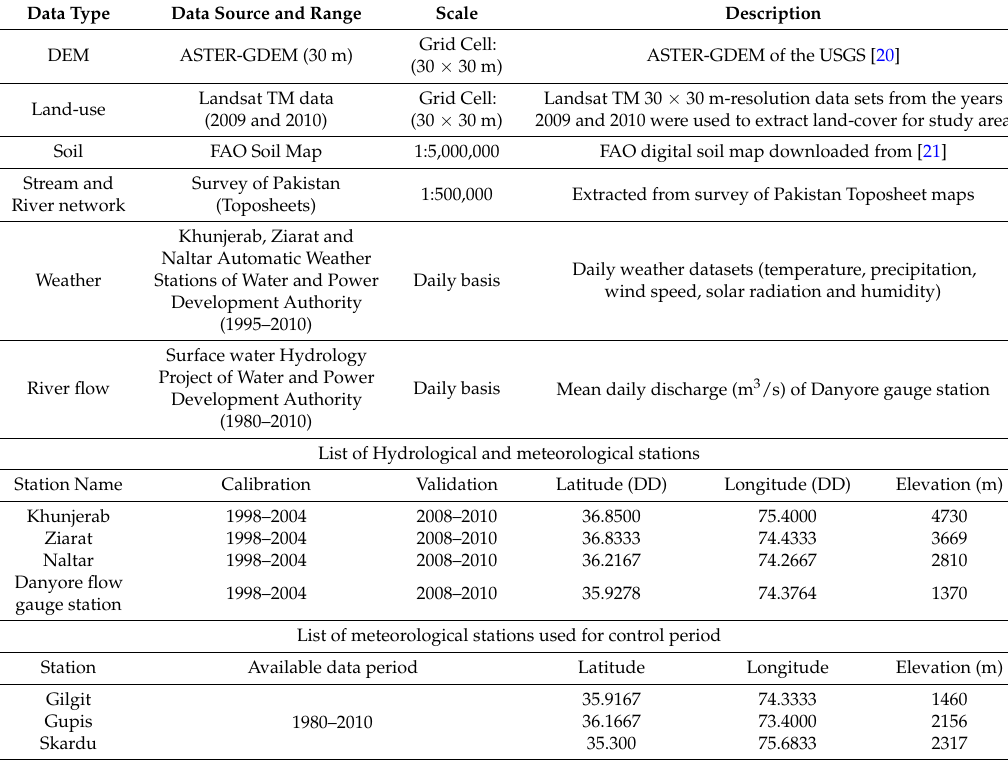
Table 1. Data source, type used for hydrological modelling and list of climate and flow gauge